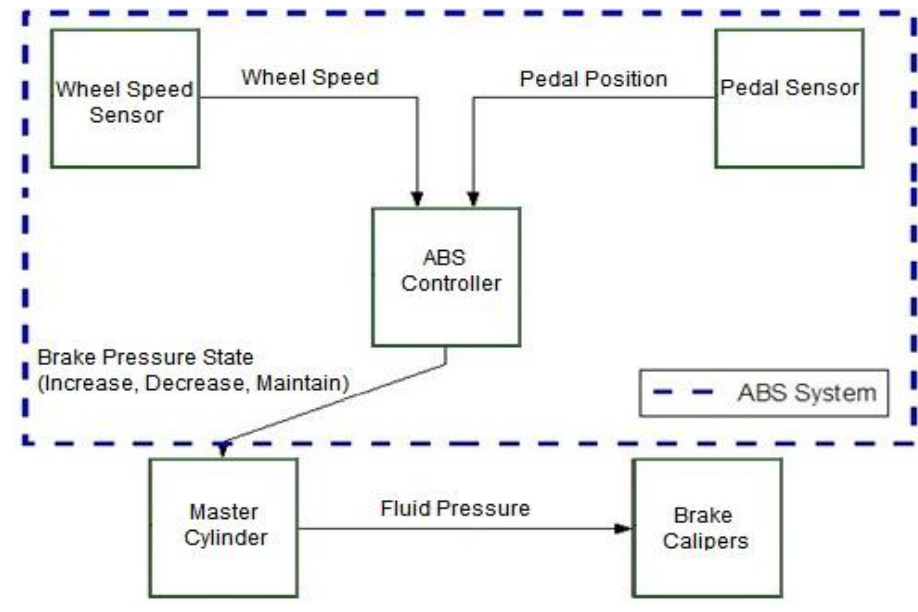
Figure 13. Illustration of an ABS system operation (brake-by-wire).